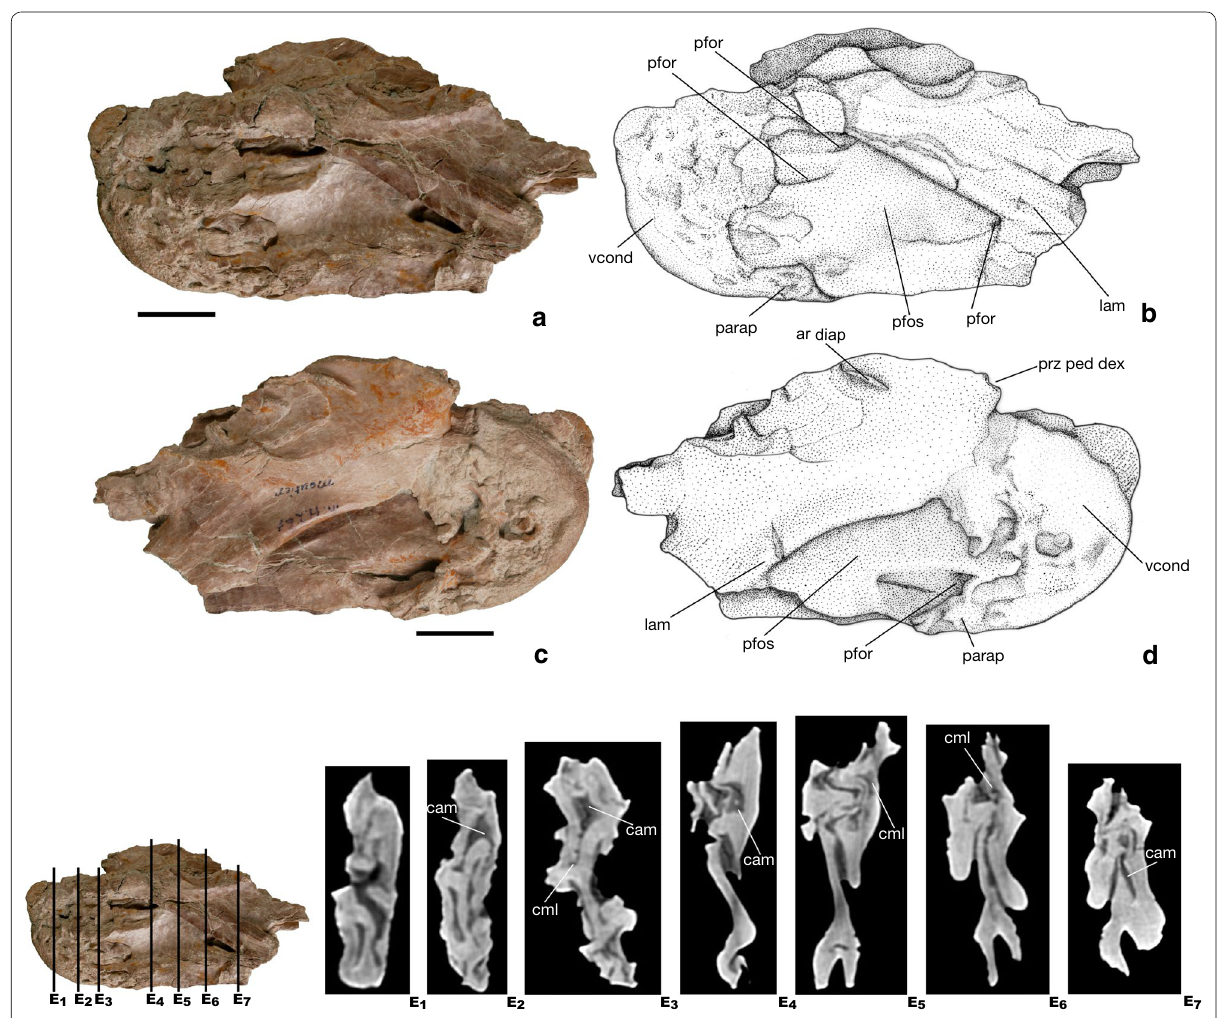
Fig. 5 Cervical vertebra NMB M.H. 267 of A. greppini . Left lateral view a as photograph and b as drawing with indication of visible anatomical details. Right lateral view c as photograph and d as drawing with indication of visible anatomical details. e Selected computed tomographic images of vertebra, (E1–E7) levels of transverse tomographic sections through the vertebra. Scale bar is 20 mm. Drawings by Serafin Padzera. ar diap area of attachment of diapophysis, cam pneumatic camera, cml pneumatic camella, lam lamina, parap parapophysis, pfor pneumatic foramen, pfos pneumatic fossa, prz ped dext right prezygapophyseal pedestal, vcond vertebral